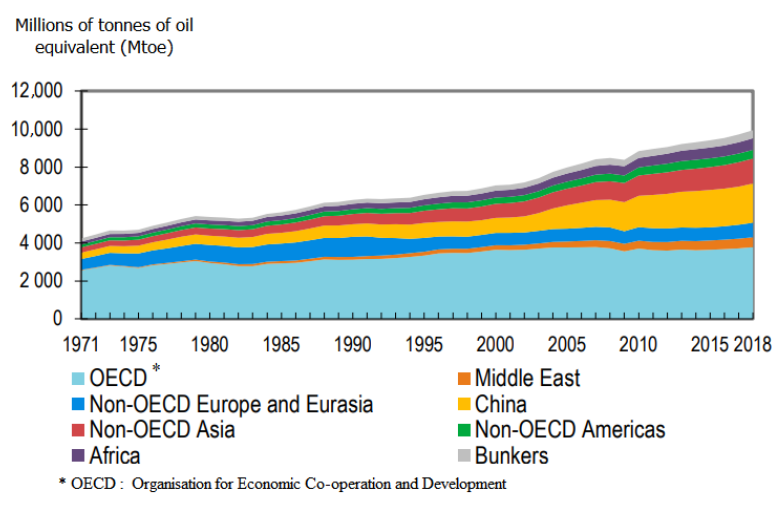
Figure 2. World total energy consumption from 1971 to 2018 by region